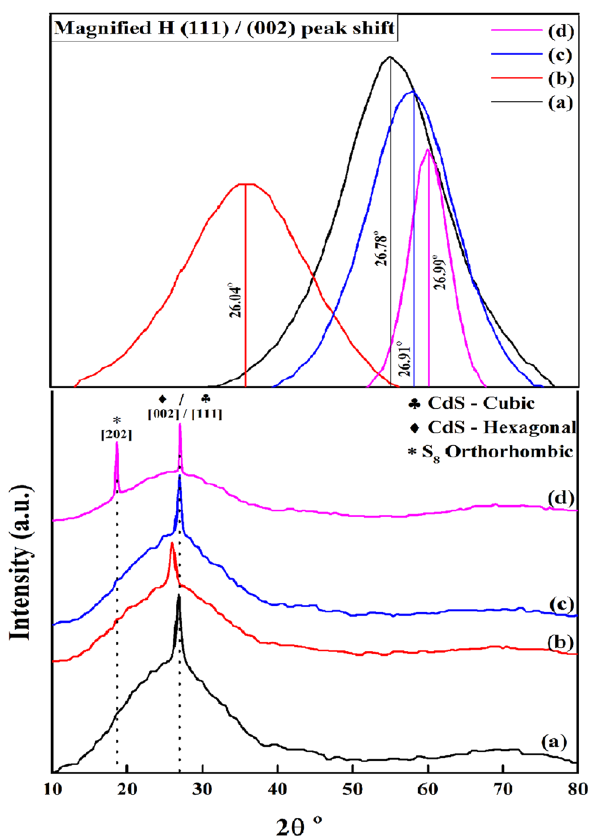
Figure 4. X-ray diffraction patterns of: ( a ) CdS; ( b ) CdS + Ag; ( c ) CdS + MPA; ( d ) CdS + Ag + MPA.